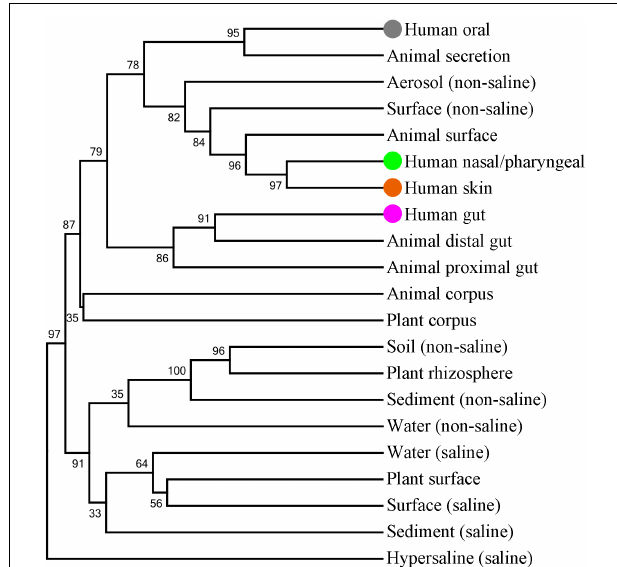
FIGURE 5 | Clustering analysis of microbial composition for human oral saliva, gut, nose/pharynx and skin samples and EMPO environmental labels. The tree was built by using the UPGMA method and Bray-Curtis similarity distance. Bootstrapping with 1,000 re-samplings was performed to determine the robustness of the clustering. The saliva, nose/pharynx, skin and gut are highlighted by gray, light green, orange-red and purple solid spheres,